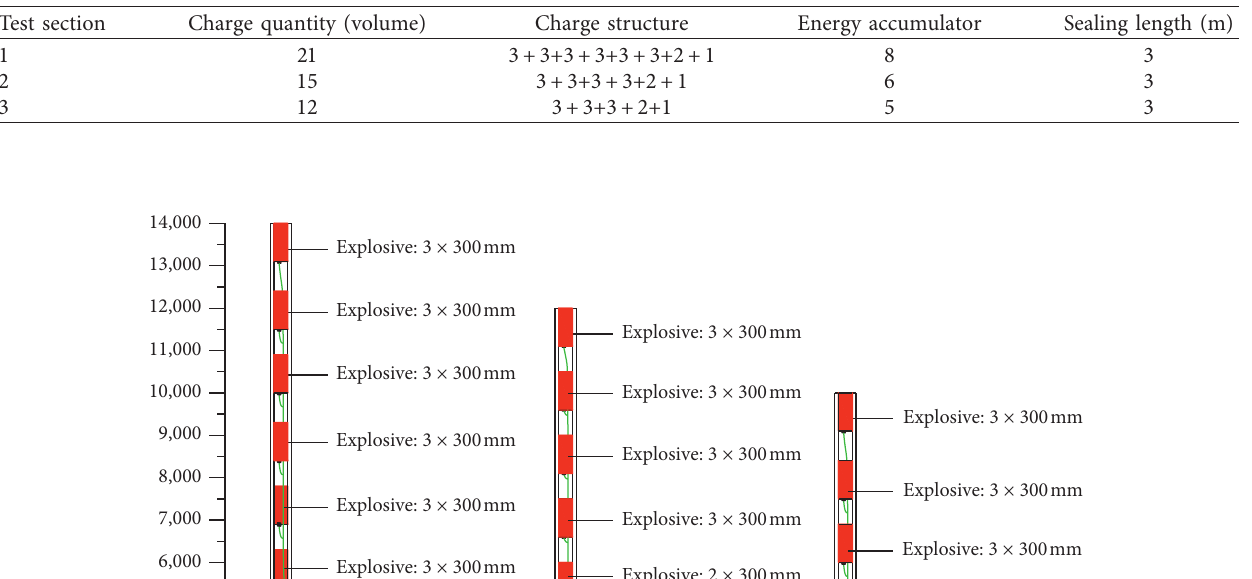
Table 6: Charge parameters of each test section.